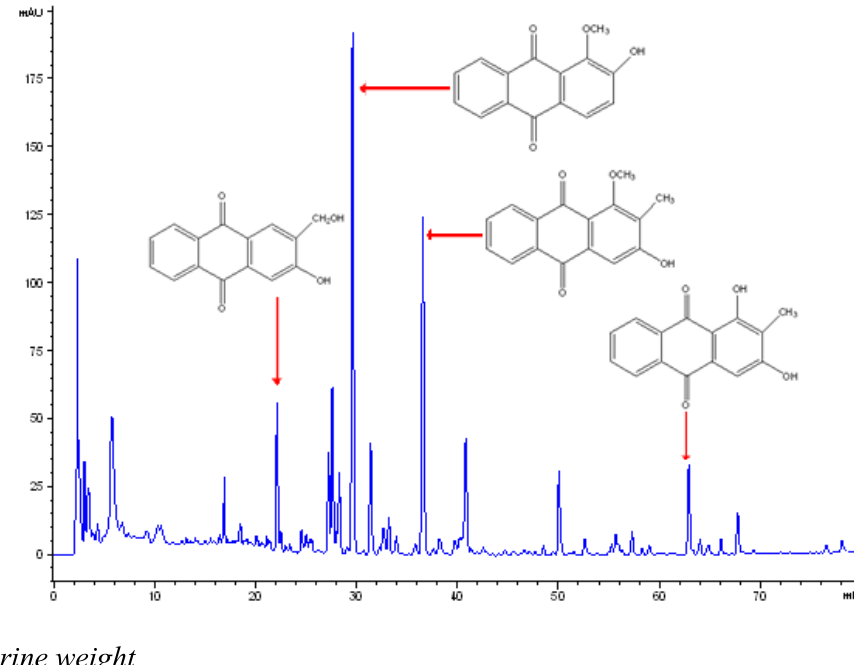
Figure 1. HPLC chromatogram of RMO. The major peaks were identified by comparison with standard compounds, and were respectively